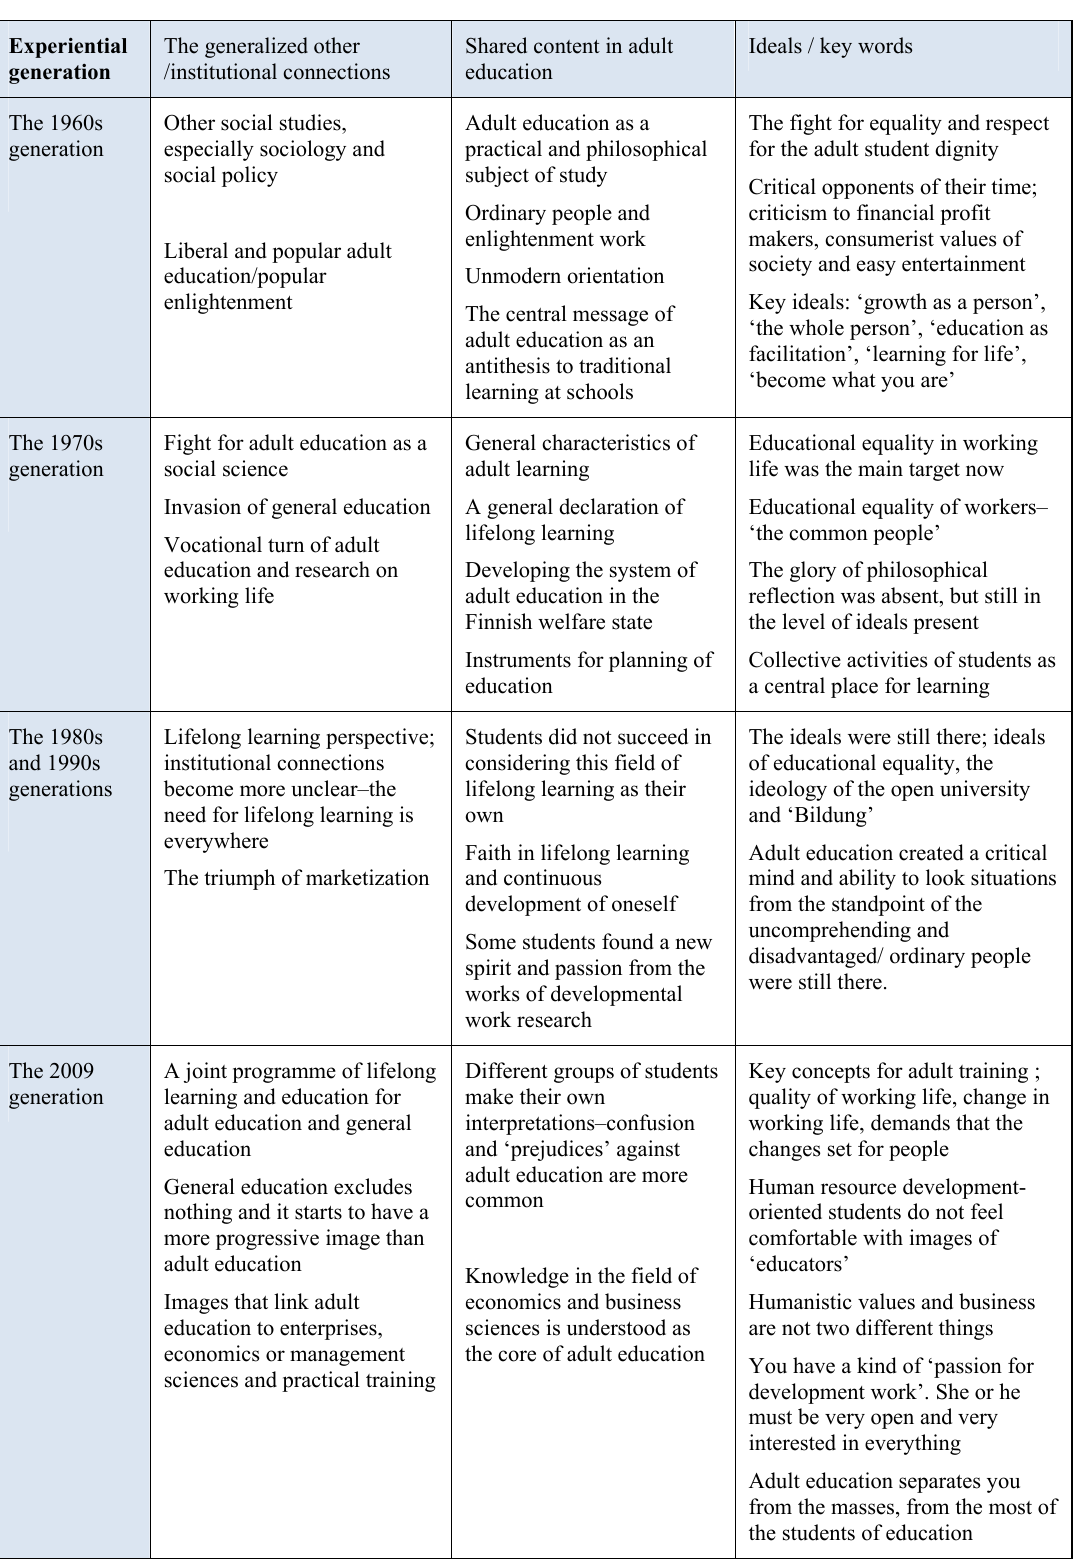
Table 1. Summary of